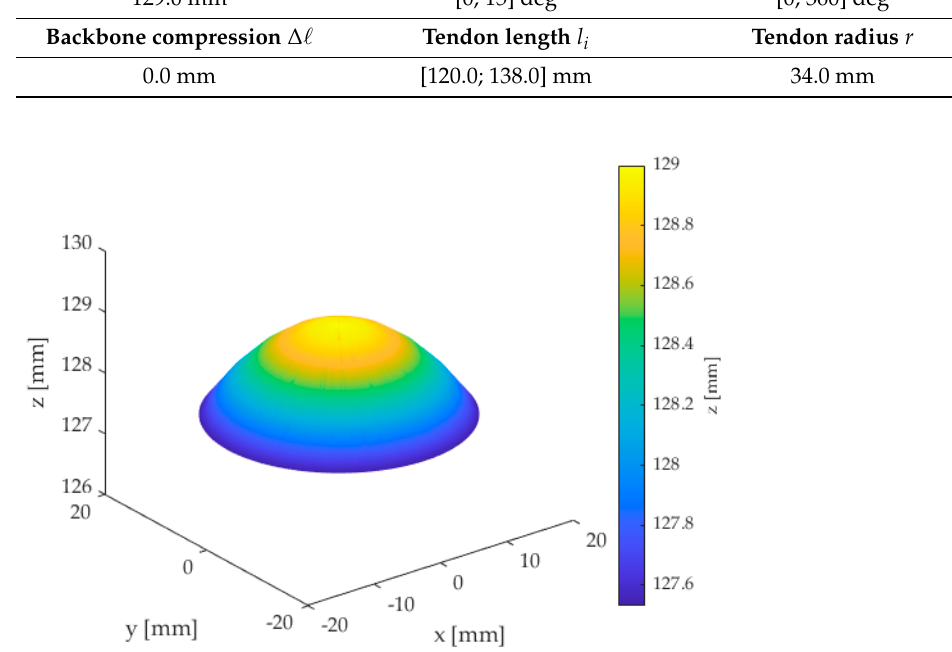
Figure 5. Workspace of the LARMbot’s torso mechanism evaluated through the proposed PCCK model with elongation and model with elongation and torsion.